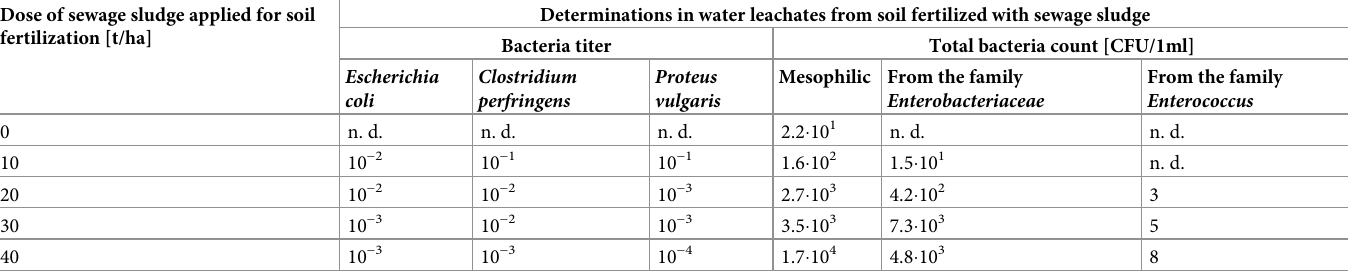
Table 4. Results of sanitary examinations of water leachates from soil fertilized with different doses of sewage sludge (after completion of the experiment). Dose of sewage sludge applied for soil fertilization